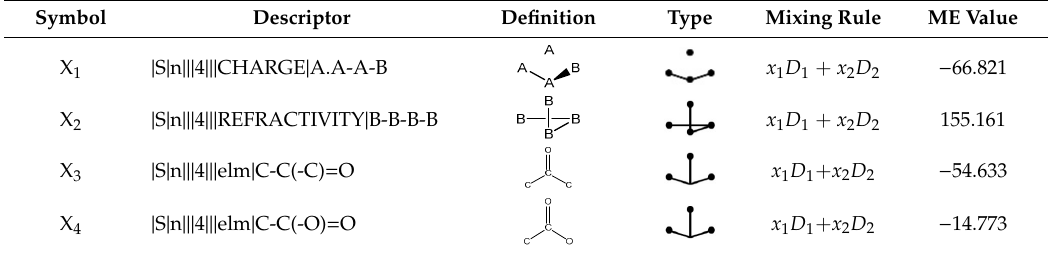
Table 1. Descriptors selected in the presented model for prediction of the Auto-ignition Temperature (AIT). Symbol